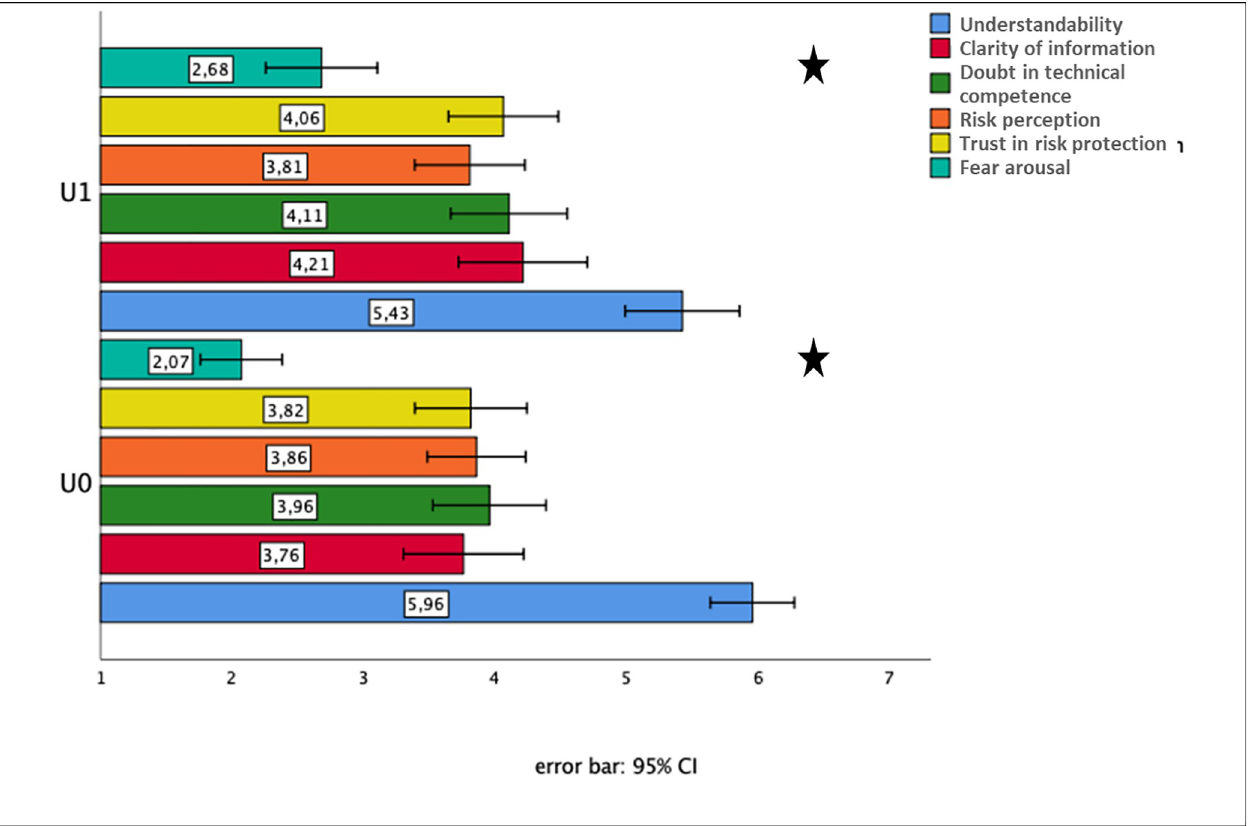
Fig 2. Effects of uncertainty description about protection by risk management (factor uncertainty) (R3). Means (with 95% confidence intervals) of the dependent variables (measured on 7-point-Likert scales) for the two levels of factor “uncertainty”—U0: no information about uncertainty, U1: information about uncertainty. N.B.: The higher the score on the Likert scale the higher is the value on the dependent variable.